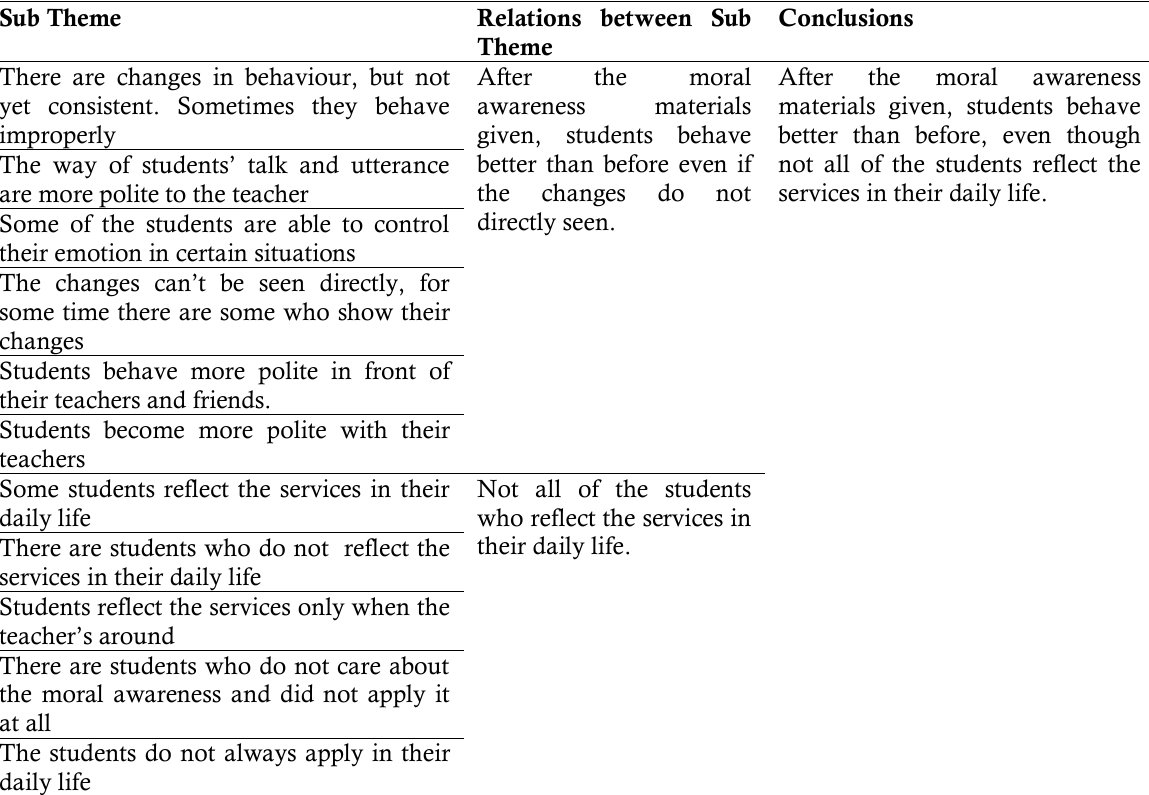
Table 3 . Changes and Applications in Students’ Daily